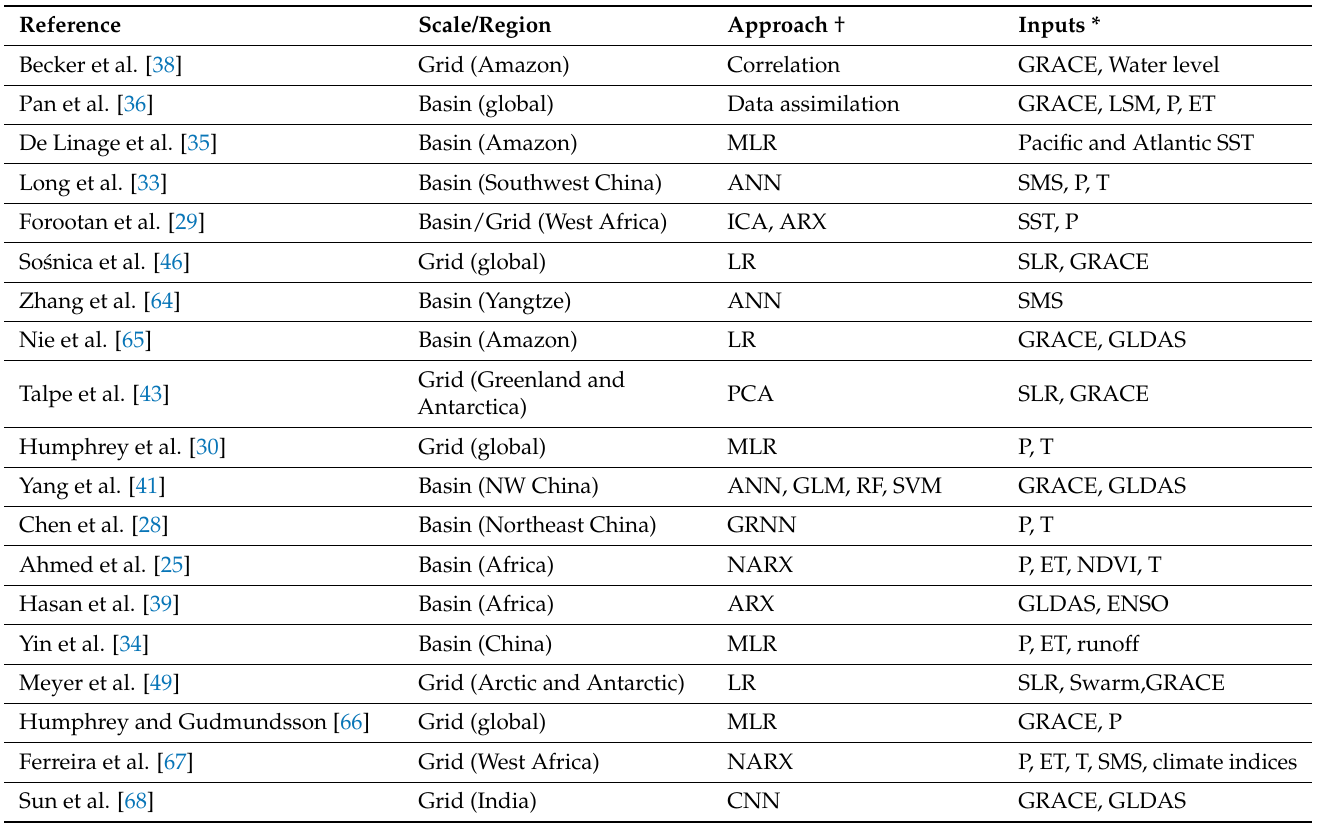
Table 1. Review of previous TWS GRACE reconstruction data and